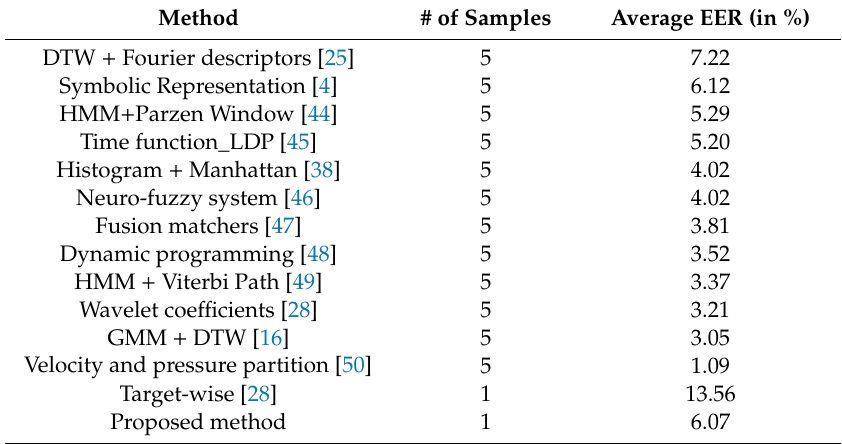
Table 9. Comparative studies of state-of-the-art methods implemented on